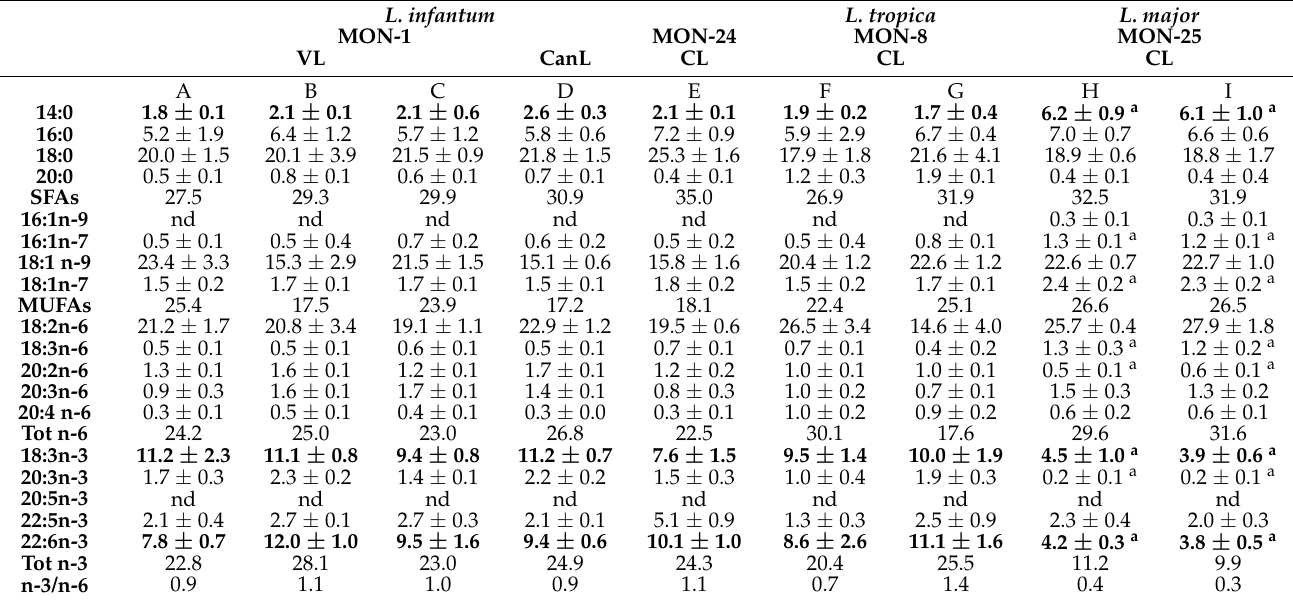
Table 1. Comparative FA composition of total lipids in various Leishmania species. Nine Leishmania strains were isolated from patients in Tunisia including five L. infantum strains (A to E) with visceral or cutaneous symptoms and canine leishmaniasis, two L. tropica (F,G), and two L. major (H,I) strains. FA composition was determined by GC analysis. Data are expressed as mole percent and as means ± SD of four independent determinations. a indicates significant differences compared to other strains by ANOVA. SFAs, saturated fatty acids; MUFAs, monounsaturated fatty acids. L. infantum L. tropica L. major MON-1